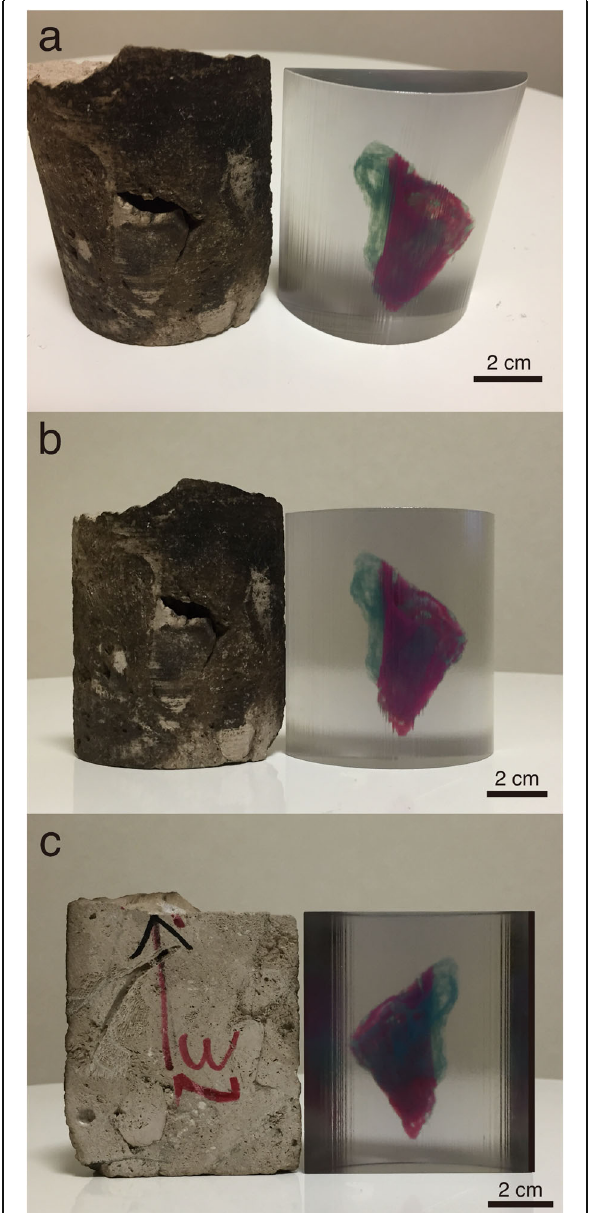
Fig. 8 Three-dimensional printed model of rudist B. Photographs of the studied core (left) and images of the 3D model of rudist B (right). a High-angle images. b Images of the external core surface. c Images of the split core surface. Magenta and cyan colors indicate the inner and outer shell layers,